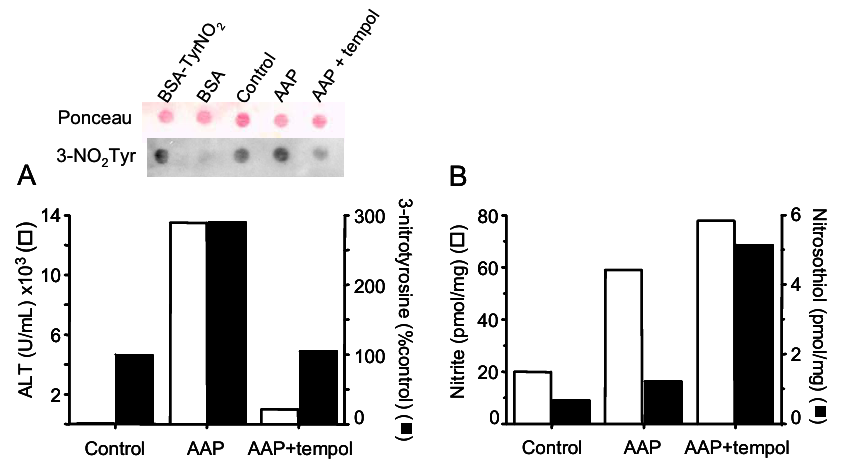
Fig. 3 – Effects of tempol in protecting acetaminophen-induced hepatotoxicity. (A) Plasma alanine aminotransferase (ALT) and 3-nitrotyrosine protein residue levels in the liver centrolobular tissue. (B) Nitrite and nitrosothiol levels in the liver centrolobular tissue. Male C3Heb/FeJ mice (18 to 20 g) were fasted overnight and treated with acetaminophen (AAP) pre-dissolved in warm saline (500 mg/kg, i.p). Tempol was administered 1 and 4 h afterwards (24mg/kg, i.p). Animals were sacrificed 6 h after AAP injection. The liver was perfused with cold saline containing 10 mM N-ethylmaleimide and centrolobular tissue was removed and homogenized as previously described (Fernandes et al. 2005). Plasma alanine aminotransferase (Tsuhako et al. 2006) and levels of 3-nitrotyrosine, nitrite and nitrosothiol in centrolobular tissues (Fernandes et al. 2005) were quantified as described in the cited references. The inset shows a typical analysis of 3-nitrotyrosine by its staining compared with protein staining; BSA and BSA-TyrNO 2 corresponds to bovine serum albumin untreated and treated with peroxynitrite/carbon dioxide used as controls. The experiments are representative of at least three control, APP- and APP-treated plus tempol